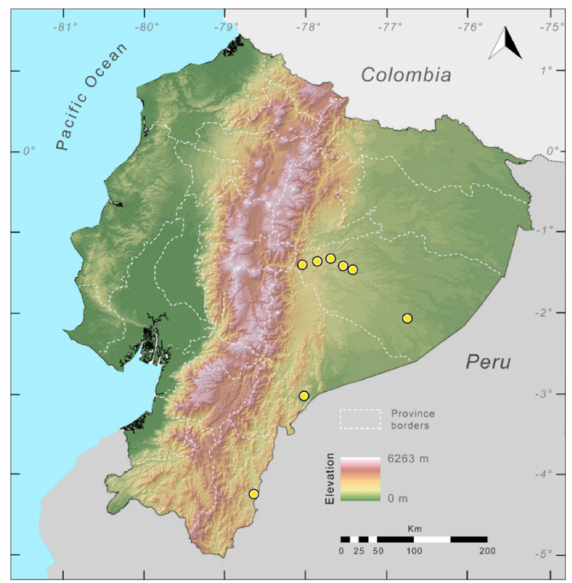
Figure 209. Distribution of Teratohyla amelie in Ecuador (yellow